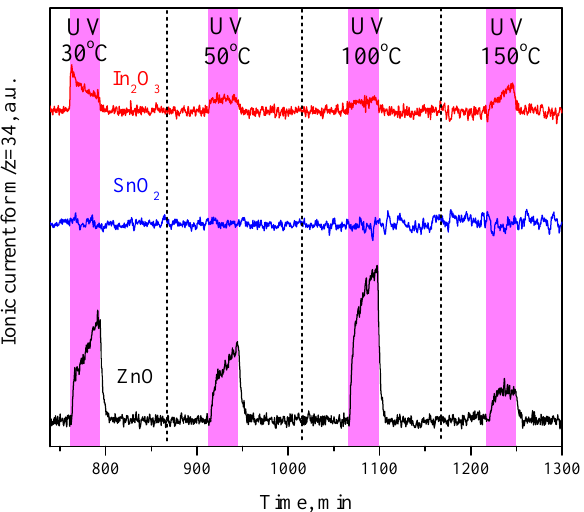
Figure 4. MS analysis of the content of mixed isotopic oxygen ( 16 O 18 O, 34 a.m.u.) in the carrier gas passed through the cell with ZnO, SnO 2 , and In 2 O 3 tablets and the effect of UV irradiation on its concentration at temperatures of 30, 50, 100, and 150 ◦ C.